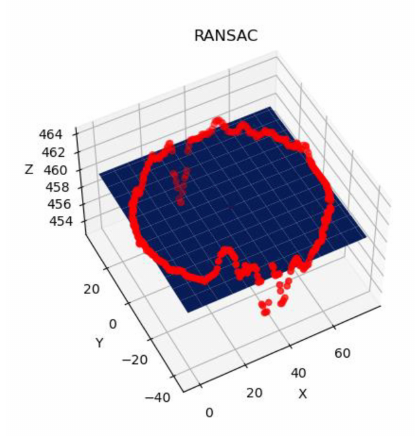
Figure 15. The fitting plane diagram of a pipeline interface.